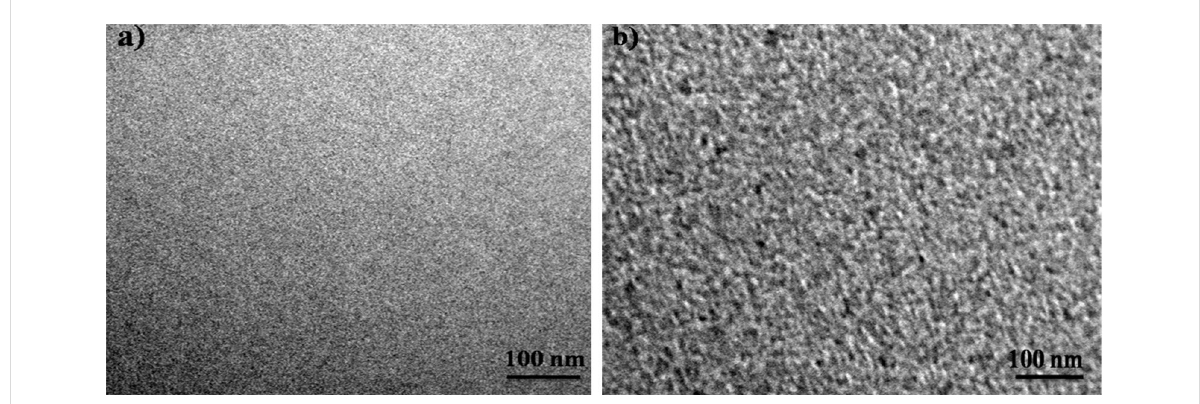
Figure 3: TEM micrographs of 2 atomic % Zn in silica, (a) pristine film, (b) irradiated at a fluence of 3 × 10 13 ions/cm 2 .